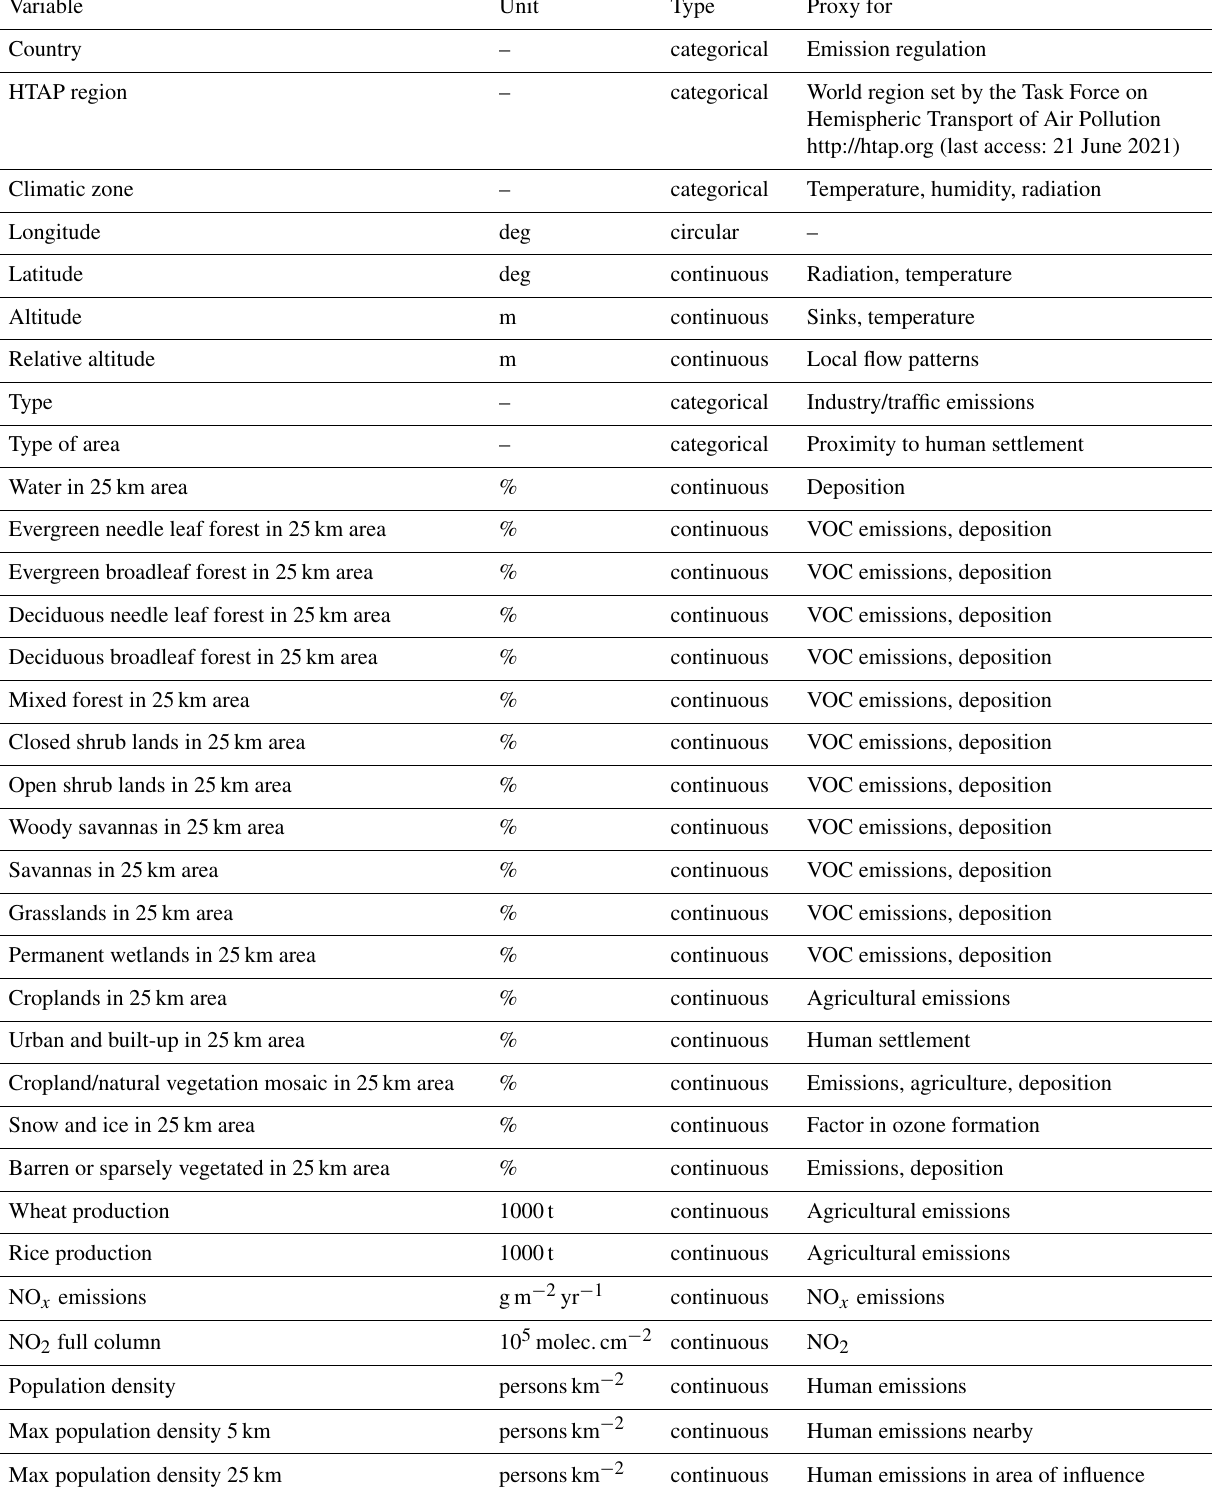
Table 1. The station metadata of AQ-Bench.